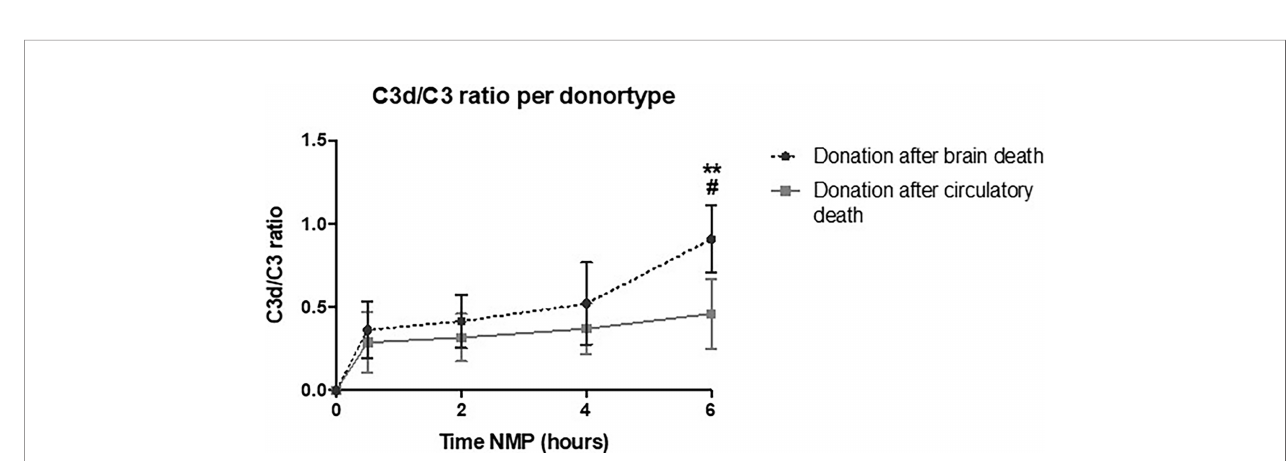
FIGURE 8 | Perfusate C3d/C3 ratio of human kidneys retrieved from brain-dead donors is signi fi cantly higher after 6 h of normothermic machine perfusion. Shown are the differences in C3d/C3 ratio during normothermic machine perfusion based on donor type. Kidneys retrieved from brain-dead donors showed signi fi cantly higher C3d/C3 ratio after 6 h of normothermic machine perfusion than kidneys retrieved after circulatory death. Data shown as median ± interquartile range. The asterisk denotes a signi fi cant difference between baseline C3d/C3 ratio and C3d/C3 ratio after 6 h of NMP of kidneys from brain-dead donors. The hashtag denotes a signi fi cant difference in C3d/C3 ratio between the two groups, brain-dead donors and donation after circulatory death. # p < 0.05, ** p < 0.01. NMP, normothermic machine perfusion.